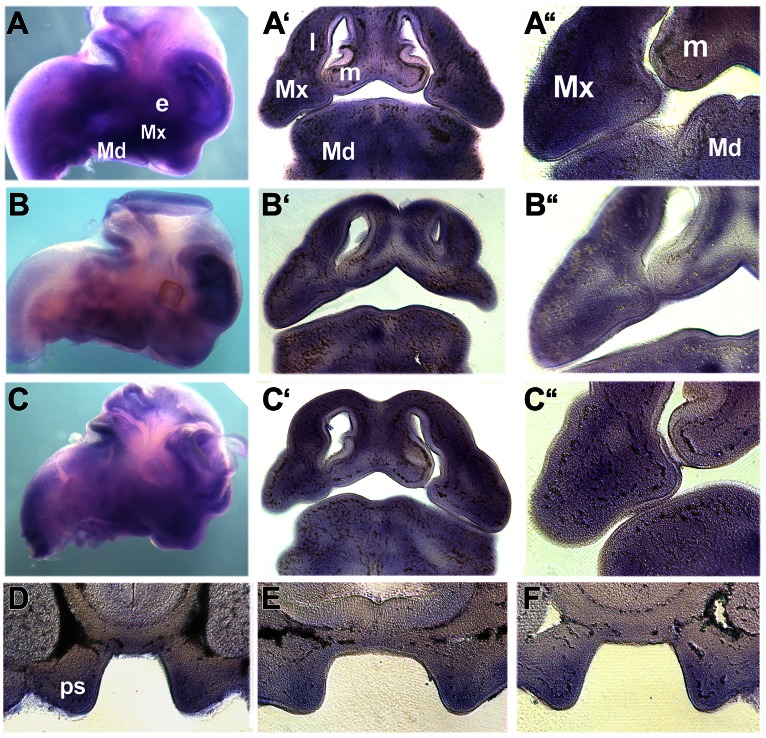
Expression of Brca1, Rad51 and E2f1 in the developing facial primordia.Whole-mount in situ hybridisation (A–F) showing the expression of Brca1 (A, D), Rad51 (B, E) and E2F1 (C, F) in E11.5 (A–C) and E12.5 (D–F) embryos. Expression is indicated by the blue/purple staining. A–C are sagittal views of the developing head whilst A’–C’ are frontal sections through the embryos shown in A–C. A’’–C’’ show high power views through the developing maxillary primordia, lateral and medial nasal processes. E–F are frontal sections through the developing E12.5 palatal shelves. e, eye; l, lateral nasal process; m, medial nasal process; Md, mandibular primordia; Mx, maxillary primordia; ps, palatal shelves.